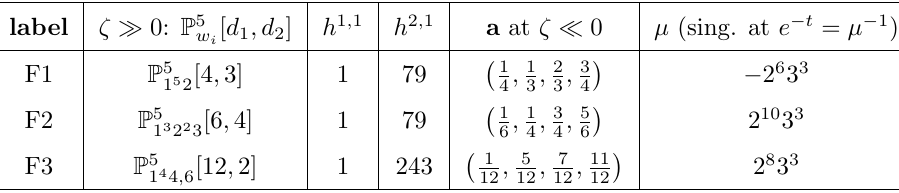
Table 3 . F -type pseudo-hybrids from U(1)